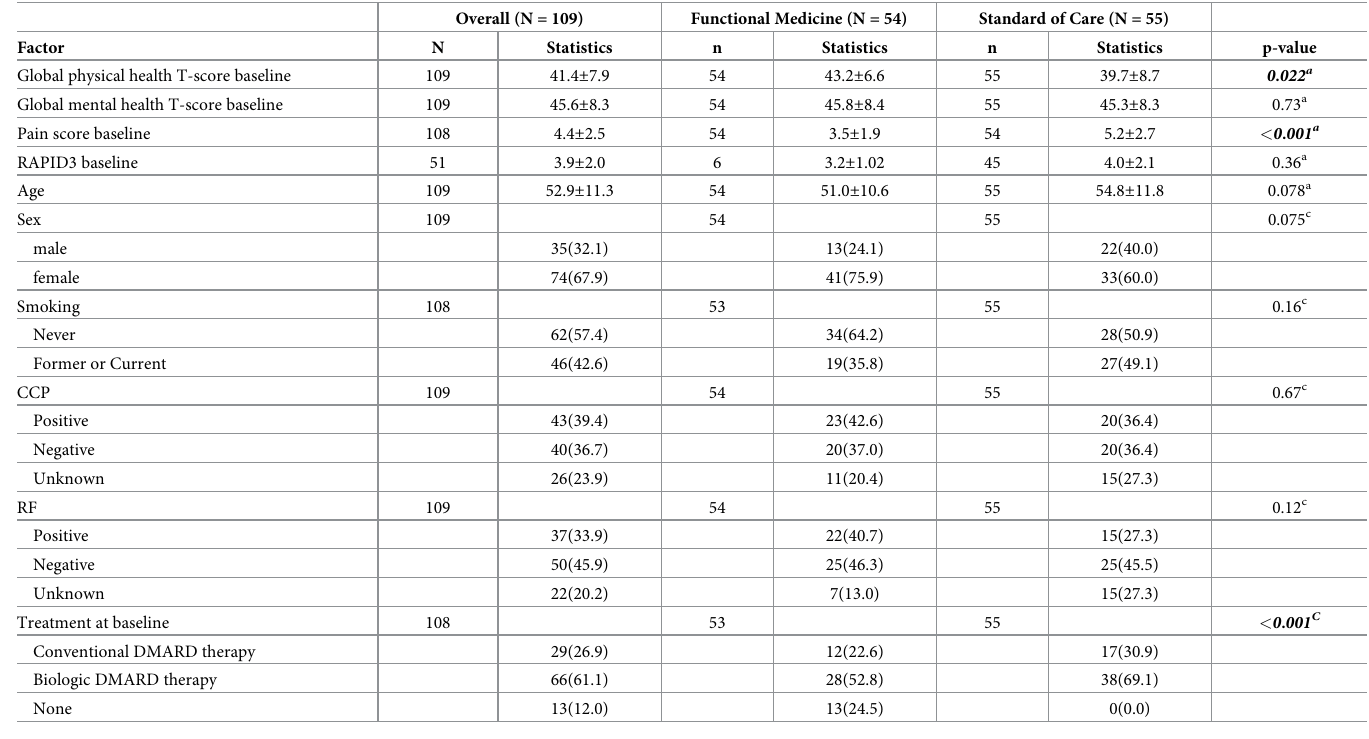
Table 1. Descriptive statistics on patient reported outcomes at baseline, demographic and clinical